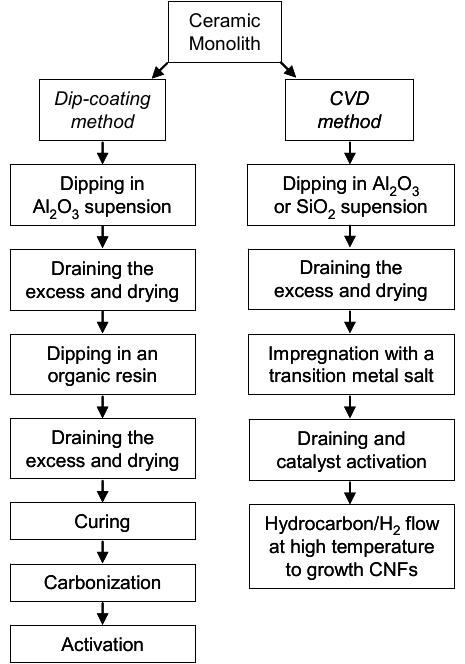
Figure 2. Preparation steps for carbon-coated